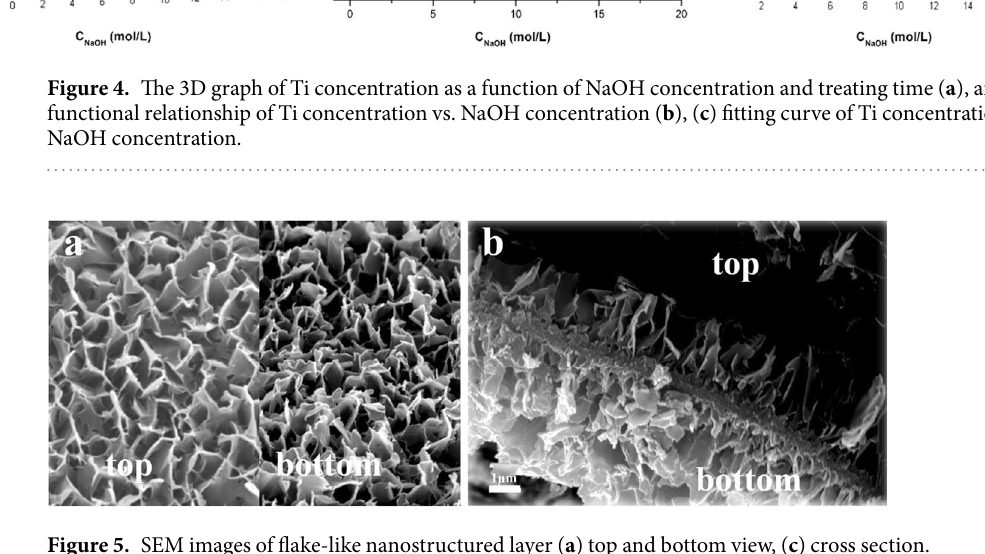
Figure 5. SEM images of flake-like nanostructured layer ( a ) top and bottom view, ( c ) cross